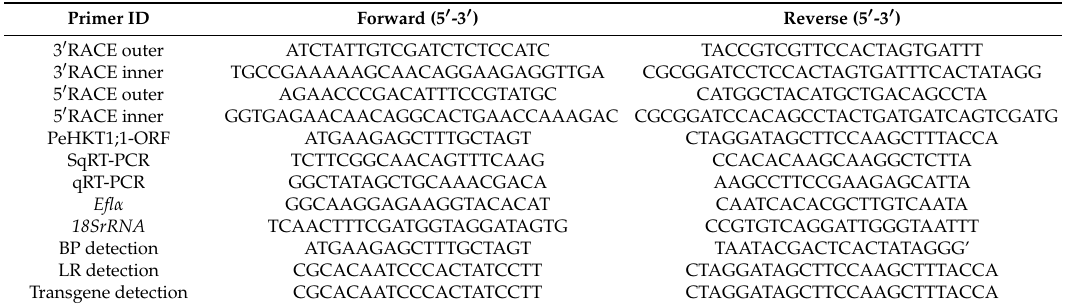
Table 1. Primers used in this